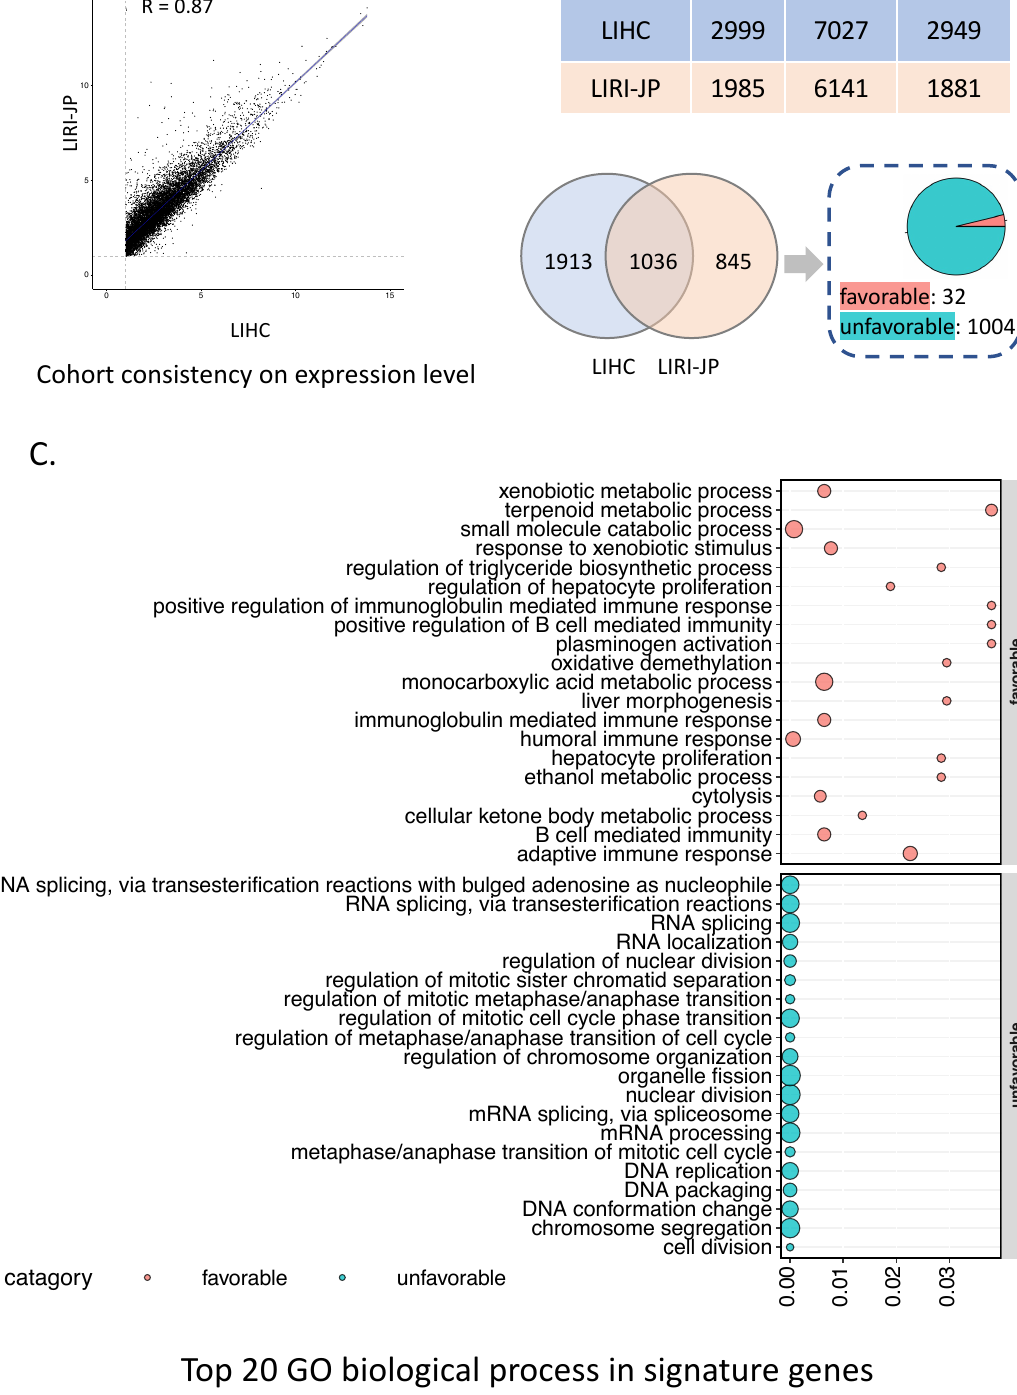
Figure 2. Identification and functional analysis of HCC SPGs. ( A ) The correlation plot shows great consistency in gene expression level between LIHC and LIRI-JP cohort. ( B ) Identification of signature prognostic genes in LIHC (marked with blue color) and LIRI-JP cohorts (marked with orange color). The table shows the number of prognostic genes in Cox survival analysis and KM analysis in two cohorts. We further identified the 1036 SPGs shared by both prognostic gene sets (Venn diagram). ( C ) Functional analysis showed the top 20 most significantly GO terms in favorable and unfavorable SPGs, presented with pink and green dots,